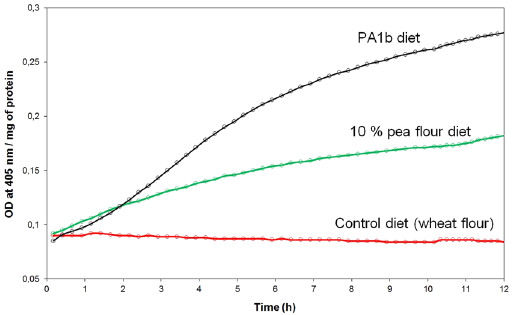
Figure 2. Caspase-3 activity on weevil midguts following PA1b intoxication. The weevils of the PA1b sensitive strain WAA42 were intoxicated for 24 h with an artificial diet composed of wheat flour (control, red curve); PA1b incorporated in the pea flour (10%, green curve); or PA1b (400 µ g/g of food, black curve). After intoxication, the midguts were dissected and the caspase -3 activities were measured using the artificial substrate DEVD-pNA.